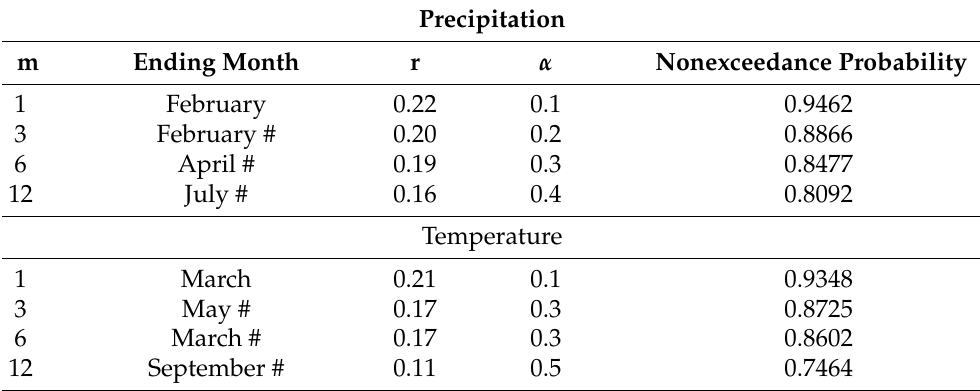
Table 2. Highest-correlated seasons of mean chronology with precipitation and temperature. The pe- riod analyzed is 1963–2012 with 1000 simulations. # means “previous year”.